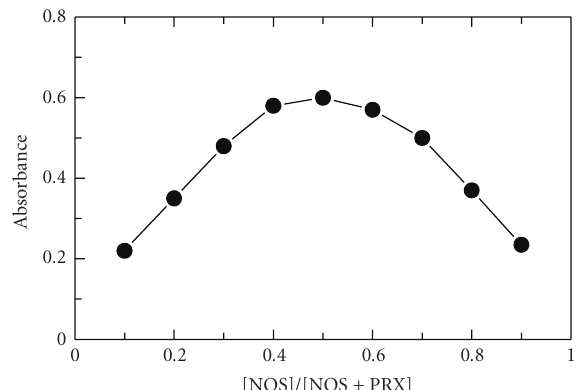
Figure 5: Job’s plot for determination of stoichiometry of the reaction between PRX and NQS. [PRX]: 5 × 10 − 3 M; [NQS]: 5 × 10 − 3 M; [PRX]+[NQS]: 1mL; Clark and Lubs bu ff er solution (pH